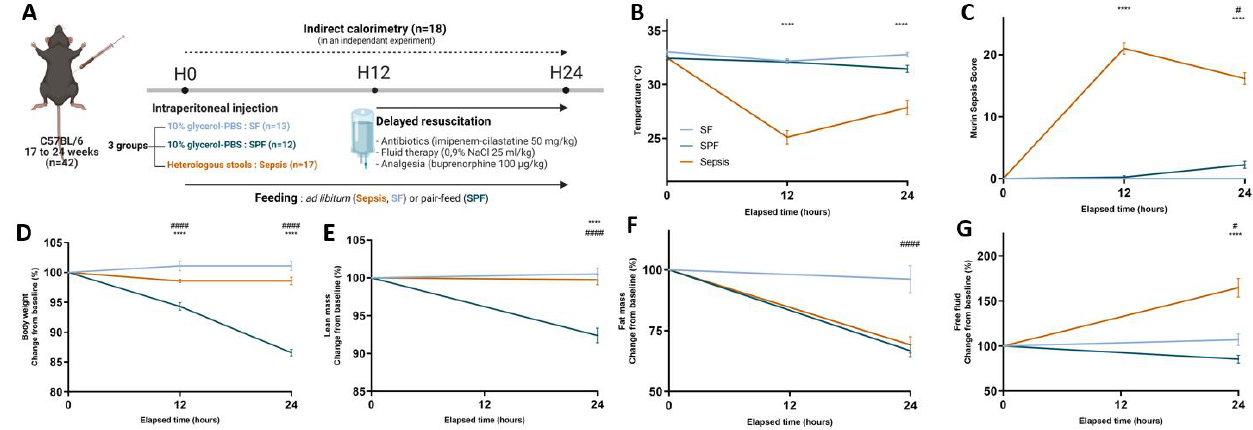
Figure 1. Clinical evolution after cecal slurry injection. ( A ) Timeline and experimental design of the main study: 42 mice were injected with 400 µ L of cecal slurry solution or 10% PBS–glycerol solution at H0 and were resuscitated at H12. Sham-fed (SF) and Sepsis mice were fed ad libitum and Sham pair-fed (SPF) mice received the same amount of food as the Sepsis mice. Muscles were harvested at H24. Eighteen mice were subjected to indirect calorimetry in an independent experiment after acclimatization in specific chambers. ( B , C ) Temperature and murine sepsis score (MSS) were respectively lower and higher in the Sepsis group than the SPF group, but were not different between the SPF and SF groups except for the MSS at 24 h, which increased by 2 points in the SPF group ( p < 0.05). ( D , E ) Change from baseline in body weight and lean mass of SPF mice significantly decreased over time compared with Sepsis and SF mice. ( F ) Change from baseline in fat mass of the Sepsis group was not different from that seen in the SPF group and both decreased in the same ranges. ( G ) Change from baseline in free fluid drastically increased in the Sepsis mice compared with the SPF mice, but was not different between SPF and SF mice. Light-blue line for the SF group (n = 13), dark-blue line for the SPF group (n = 12), and orange line for the Sepsis group (n = 17 and 13 for body composition). Data are expressed as means with SEM and analyzed using a two-way ANOVA test. # SPF vs. SF and * Sepsis vs. SPF. # p < 0.05, **** p < 0.0001, #### p <